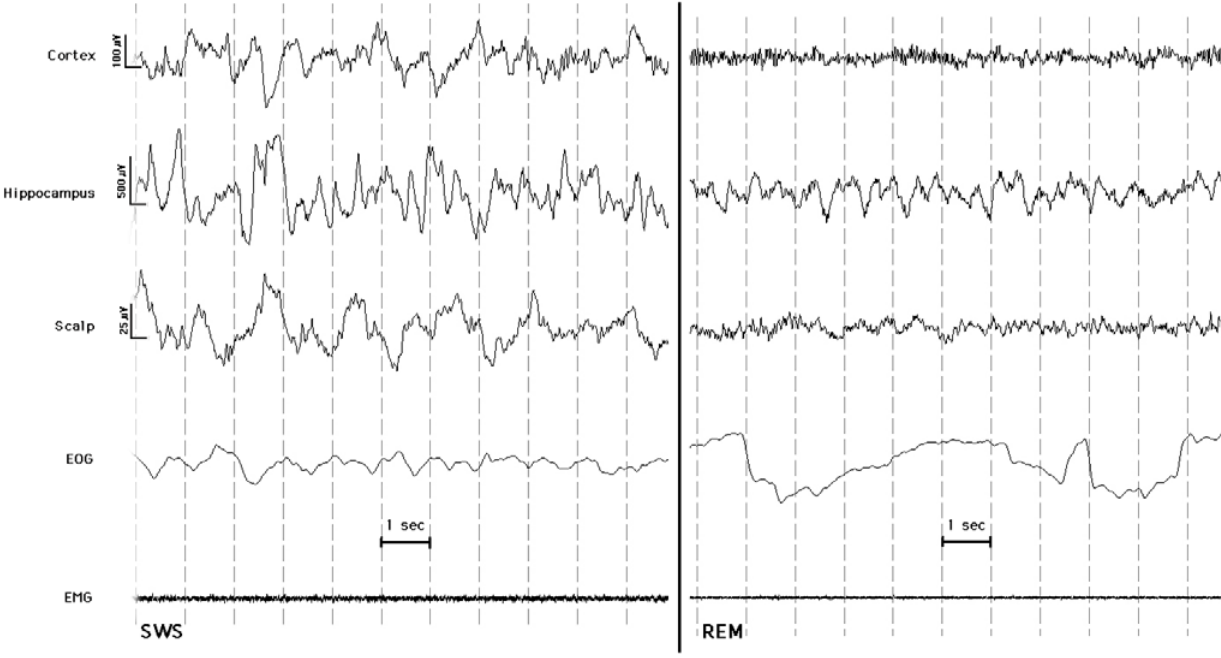
Figure 3. Examples of EEG patterns recorded from intracranial (cortex and hippocampus) and scalp electrodes during slow wave sleep (SWS) and rapid eye movement sleep (REM). Electrooculogram (EOG) and chin electromiogram (EMG) are also reported. See text for other methodological details about recordings. A clear slow rhythm is present in the hippocampal recording also during REM sleep.